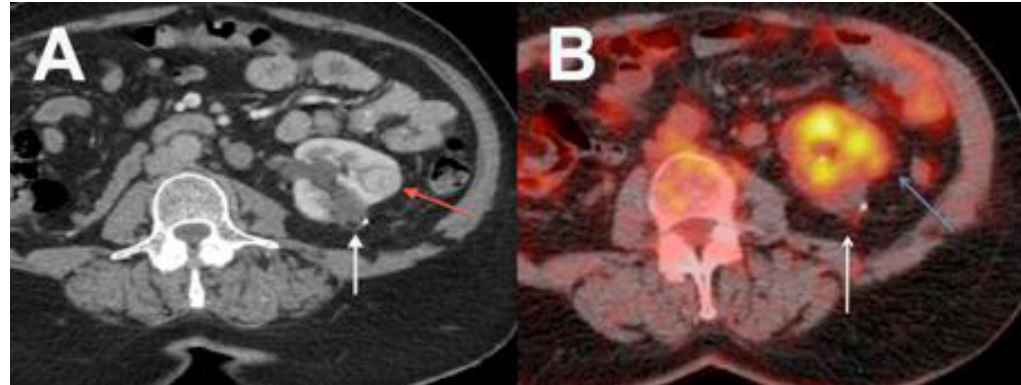
Figure 3. Imaging at 15 months follow-up of patient number 5. A , Intravenous contrast-enhanced CT scan in patient number 5 showing a non-enhancing zone (white arrow) at the side of the renal lesion treated with LCA. A second solid lesion with clear contrast enhancement (red arrow) was noticed. B , At 18F-FDG PET-CT, the ablation zone showed no metabolic FDG uptake (white arrow). The blue arrow indicates the region of the metachronous RCC with FDG uptake (SUV